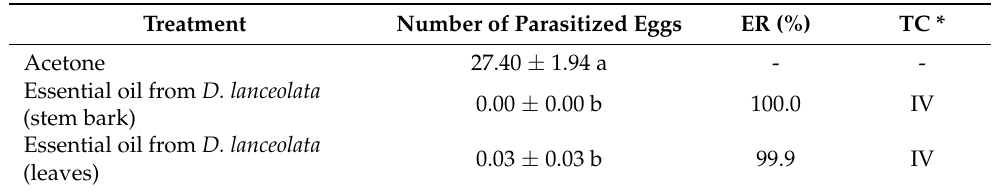
Table 5. Number of eggs and reduction percentage parasitized by females of Trichogramma pretiosum when exposed to eggs of Ephestia kuehniella treated with essential oils from the leaves and stem barks of Duguetia lanceolata